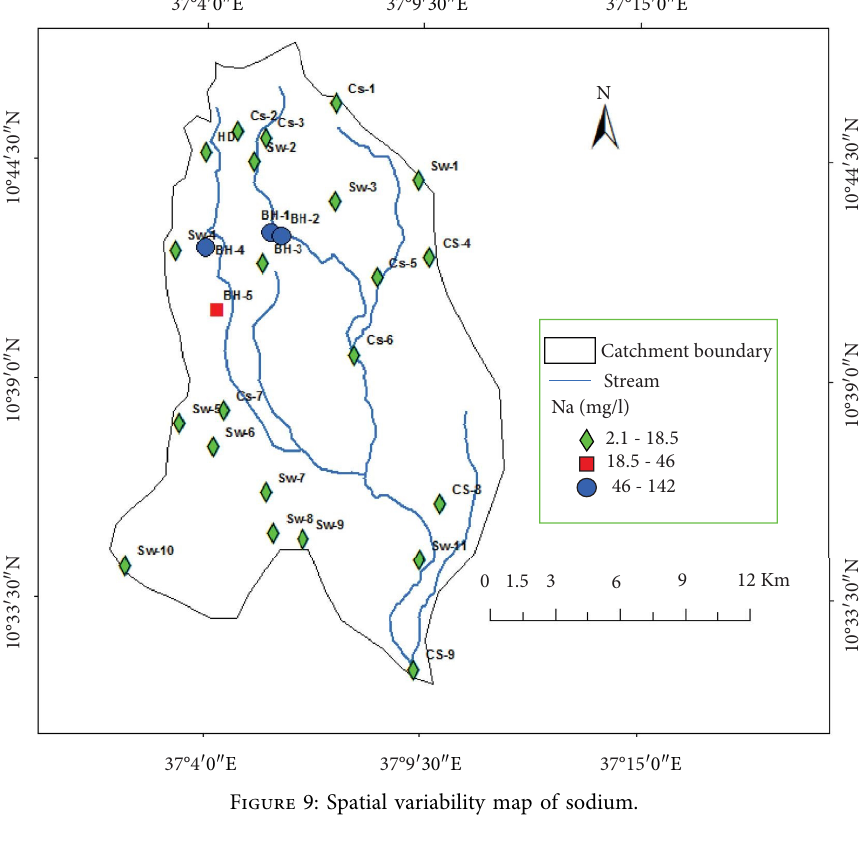
Figure 9: Spatial variability map of sodium.